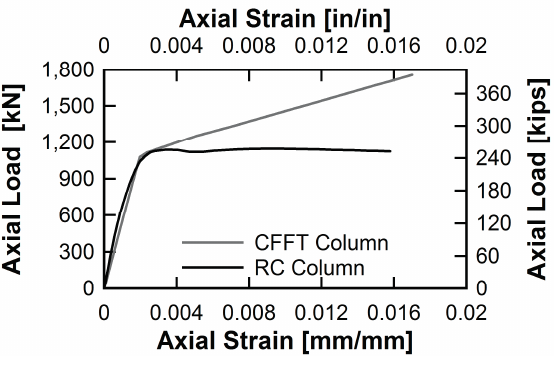
Figure 4. XTract axial load-strain curve for RC and concrete-filled fiber reinforced polymer (FRP) tube (CFFT)